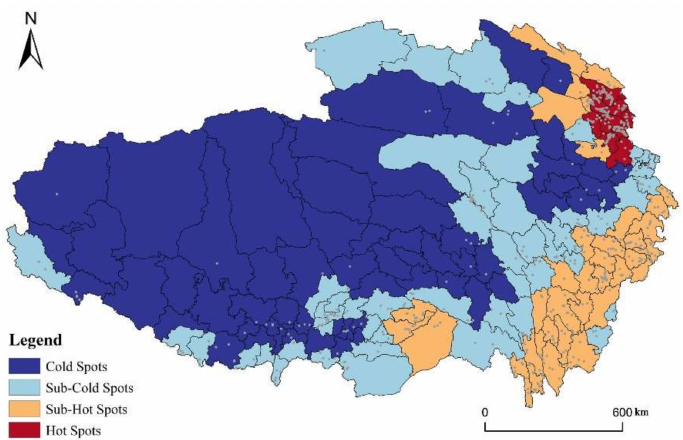
Figure 5. Spatial differentiation of cold and hot spots of RT villages in